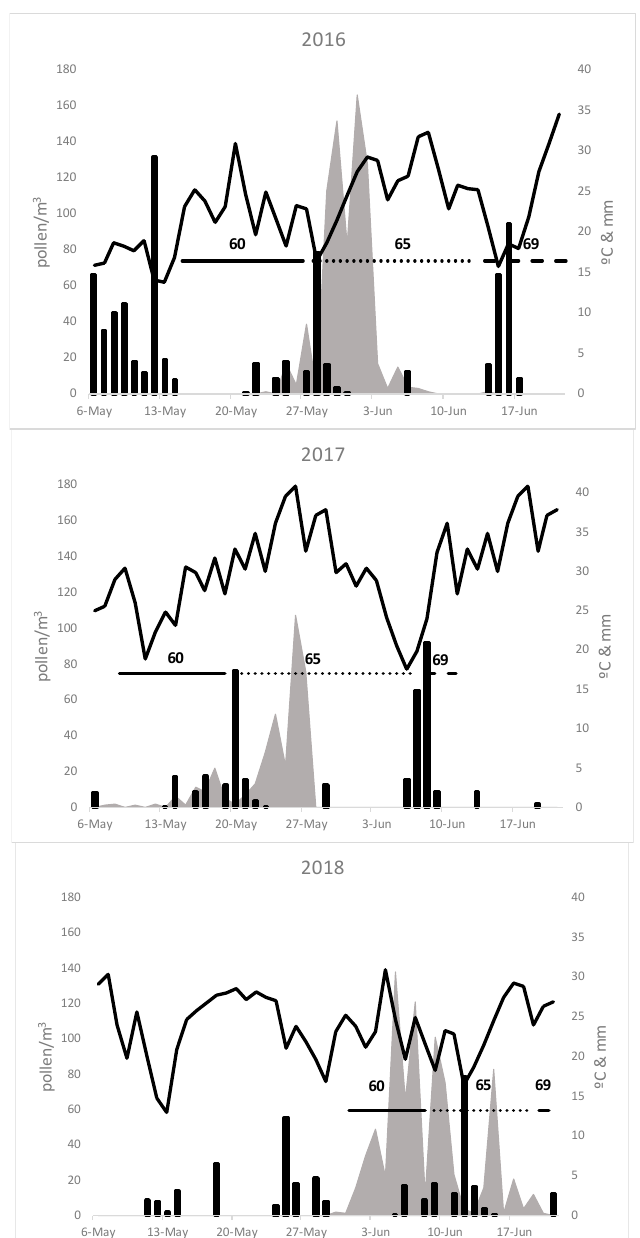
Figure 5. Dynamics O. europaea L. airborne pollen concentration (grey peaks) and daily meteorological parameters (maximum temperature in lines and rainfall in bars). In lines, duration of stage 6 (flowering) with the different phenophases (horizontal line): 60 beginning of flowering, 65 full flowering: 50% of flower open, and 69 end of flowering.